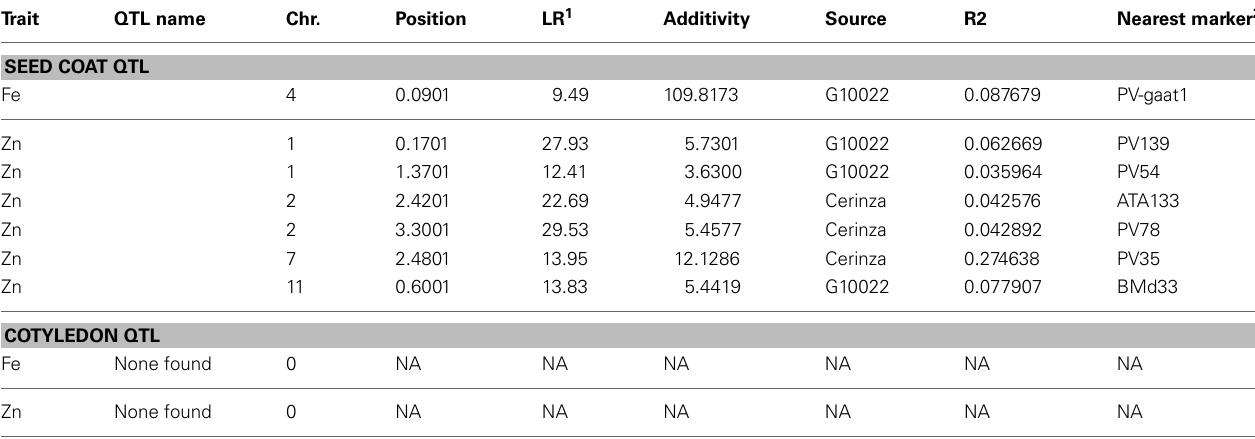
Table 4 | Quantitative trait loci for seed coat iron and zinc concentration identified by composite interval (CIM) mapping analysis in the advanced backcross population derived from the wild donor parent (G10022) and the recurrent cultivated parent